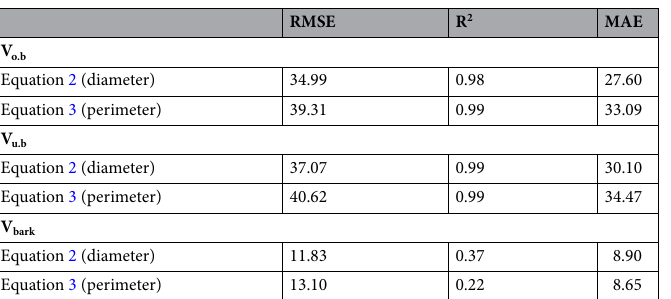
Table 1. RMSE (root mean square error), R 2 (coefficient of determination) and MAE (mean absolute error) of volume estimations with diameter (Eq. 2) and perimeter (Eq. 3) as input for the calculation to reference volume obtained by xylometry for the volume over bark (V o.b. ), volume under bark (V u.b. ) and bark volume (V bark ) of wood